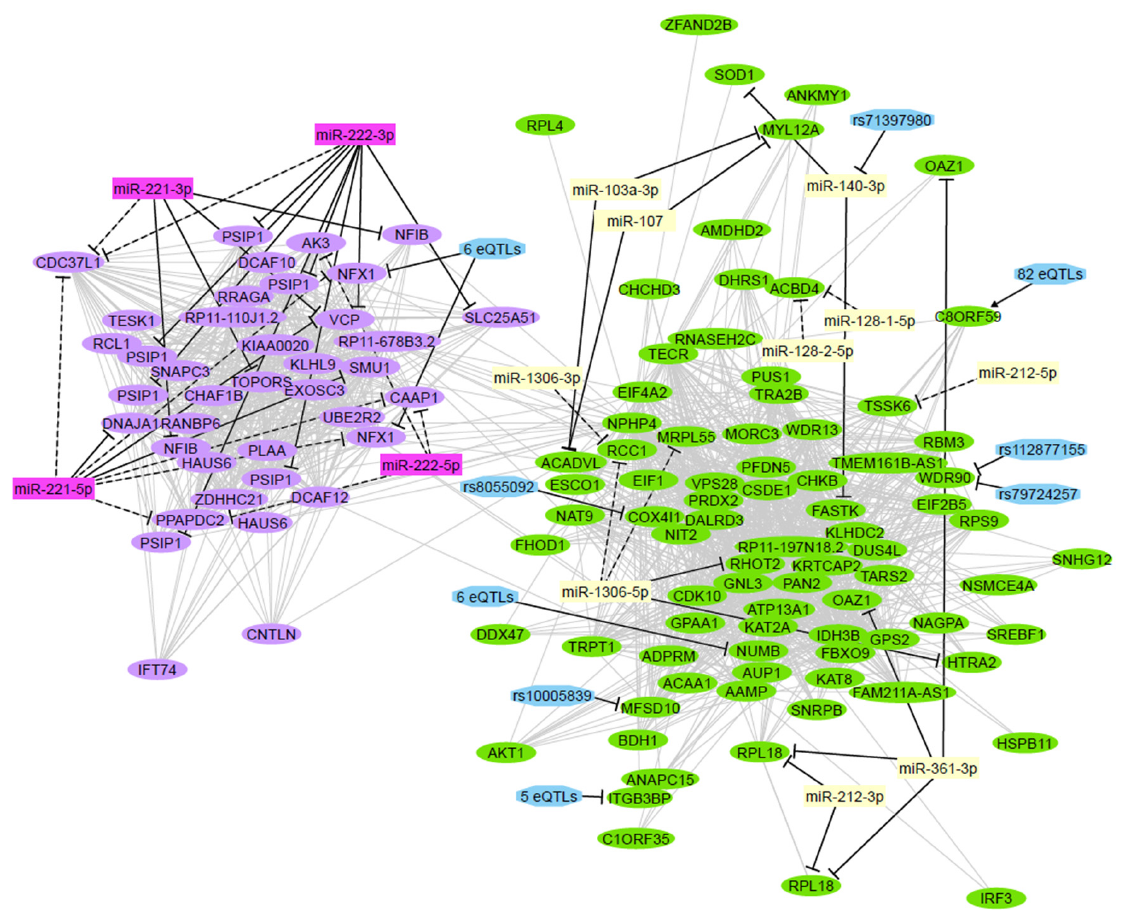
Figure 4. Integration of significant networks. The mRNA transcripts (oval nodes) from the lavenderblush3 and darkolivegreen modules are arranged based on coexpression similarity (grey edges). Regulatory interactions (black edges) indicate inhibition (bar-headed arrow) or activation (arrow). The colors of miRNA nodes indicate their membership in the plum and ivory coexpression networks. Four miRNA isoforms (rectangular nodes) were identified, either using experimental methods (solid edges) or in silico predictions (dashed edges), to regulate the expression of genes in the lavenderblush3 network module. In addition, 6 eQTLs (hexagonal nodes) may regulate the expression of the NFX1 gene. Genes in the darkolivegreen module have 10 validated or predicted regulatory miRNAs and 97 regulatory eQTLs. Finally, the ivory miRNA miR-140 may be regulated by the miR-QTL rs71397980. eQTL, expression quantitative trait loci; miR-QTL, microRNA expression quantitative trait loci.